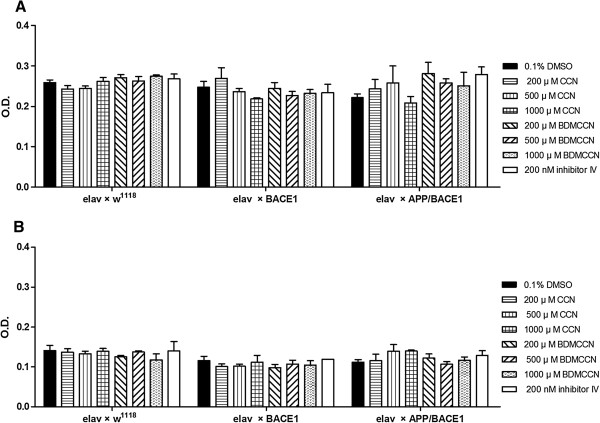
Effect of curcumin, bisdemethoxycurcumin, and β-secretase Inhibitor IV supplementation on adult flies feeding behavior of elav-Gal4/+, elav < BACE-1, and elav < APP/BACE-1 female (A) and male (B) flies.n = 45 flies. Each bar represents standard error.